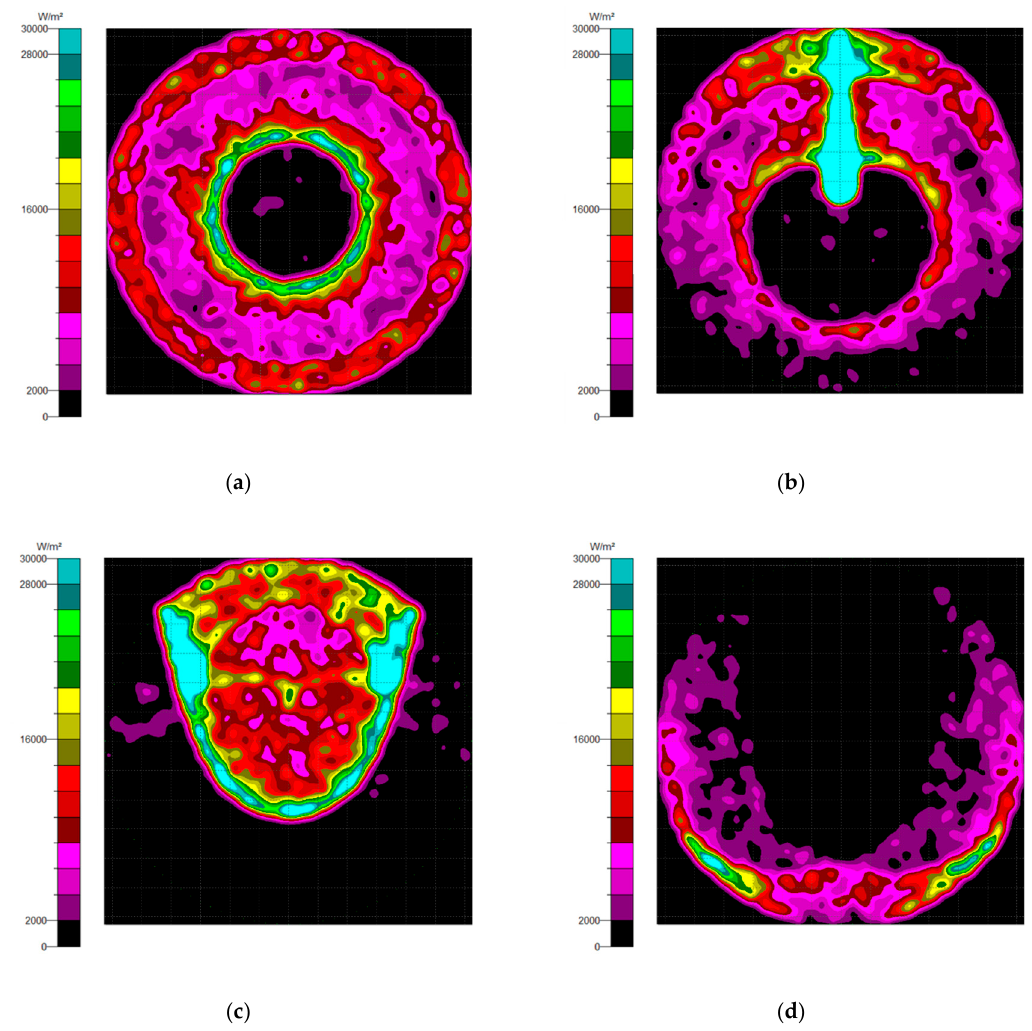
Figure 13. The irradiance distribution of the solid-CPC with misalignment angles of ( a ) 0°, ( b ) 10°, ( c ) 20°, and ( d ) 30°.